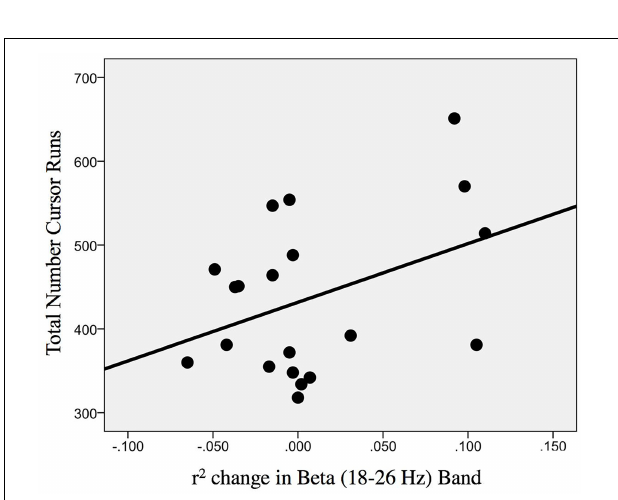
FIGURE 9 | Association between the change in r-squared values (Beta band, 18–26 Hz) as the result of BCI training with the total number of cursor trial (i.e., intervention) runs [ r (20) = 0.393; p = 0.043].